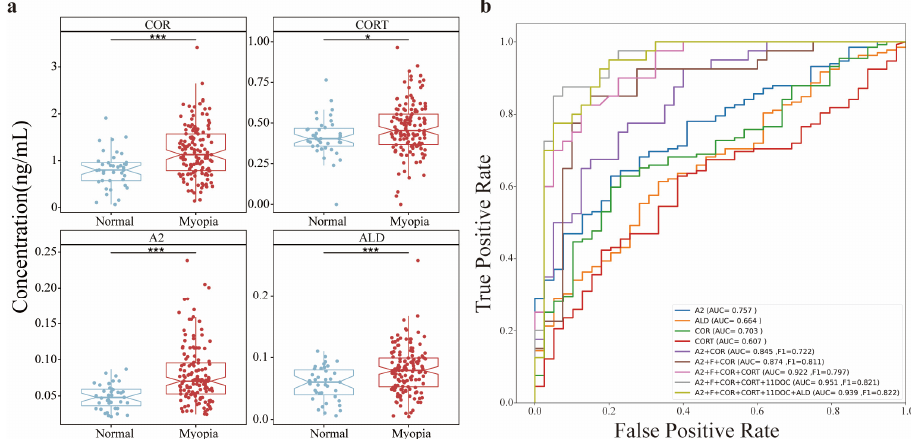
Figure 4. Correlation analysis of the axial length of the eye and the abundance of AH steroid hormones. ( a ) Comparison of the abundance of the 4 steroid hormones COR, CORT, A2 and ALD between the two groups with axial lengths ≥ 24 mm and <24 mm (* represents p value < 0.05, and *** represents p value < 0.001). ( b ) Discriminative prediction of the axial length of the eye based on the abundance of AH steroid hormones using the SVM model.